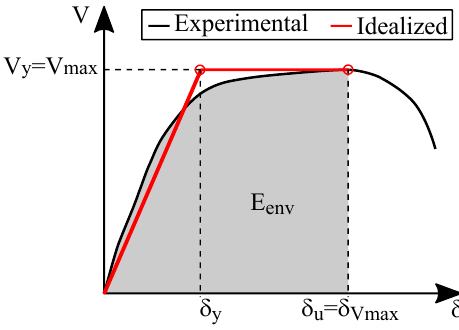
Figure 14. Idealization of the envelope curve.